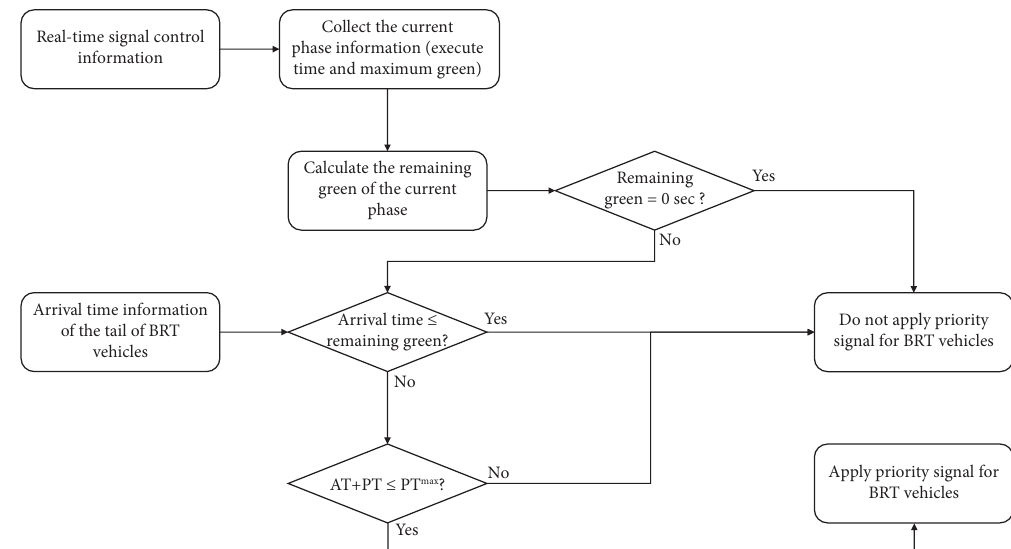
Figure 6: Algorithm of signal priority control for BRT vehicles.